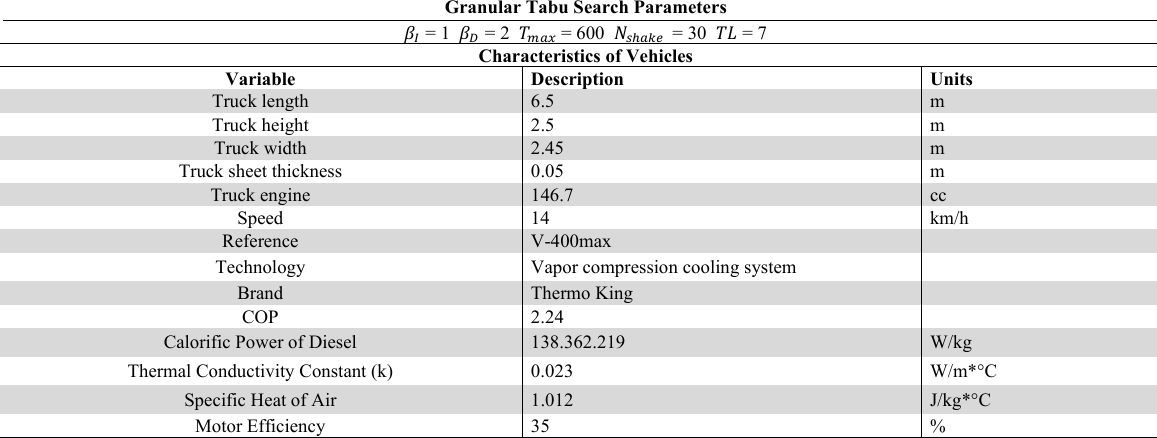
Granular Tabu Search Parameters